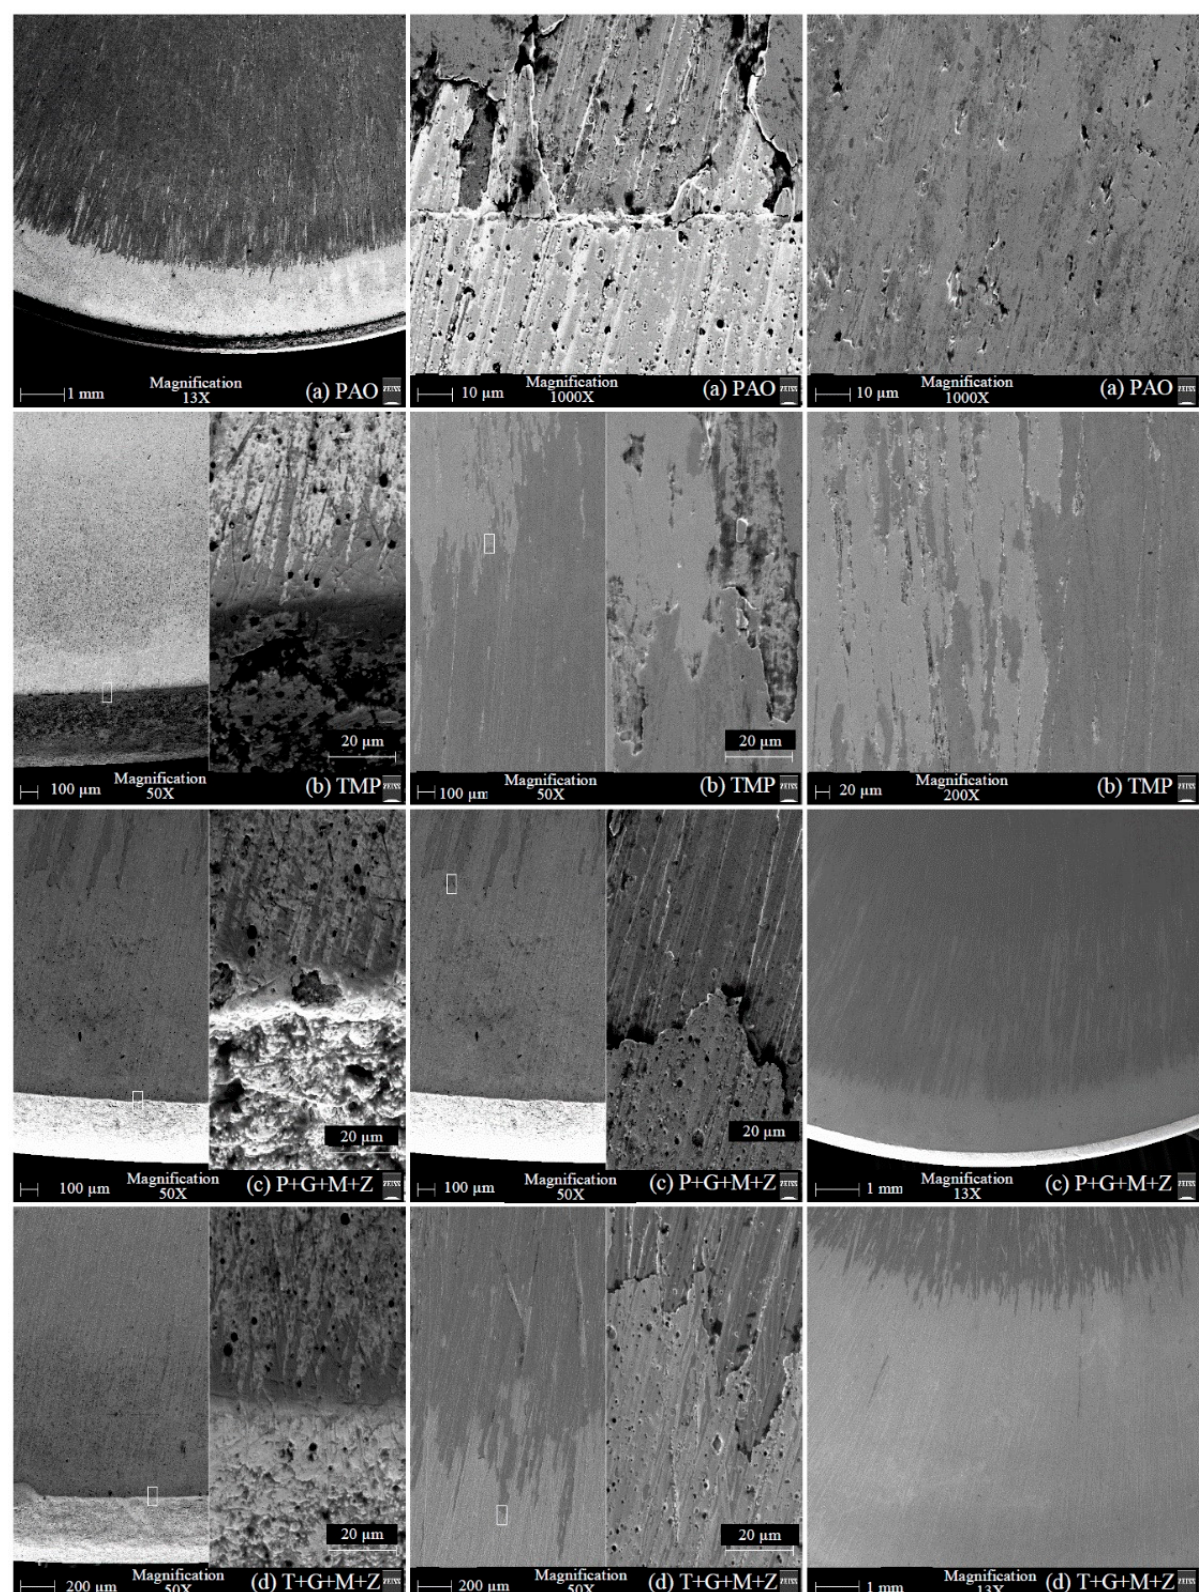
Figure 19. SEM micrographs of a-C:H:W-coated tappets after testing under various conditions in combination with a-C:H:W-coated camlobes in the presence of PAO-based and TMP-based lubricants.